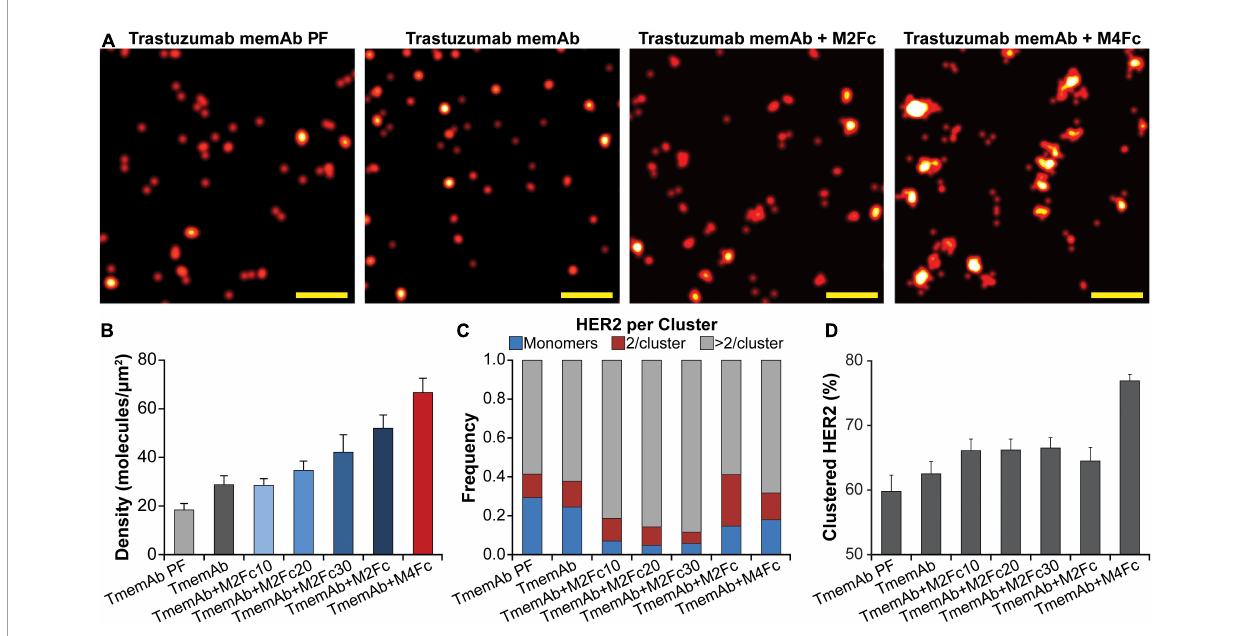
FIGURE3 Trastuzumab memAb and multivalent meditopes induce HER2 reorganization. (A) SMLM images of AF647 labeled trastuzumab memAb (TmemAb) targeting HER2 on BT-474 cells. Live cells were incubated with 10 nM TmemAb-AF647, alone or premixed with 10 nM multivalent meditope (i.e., M2Fc and its variants or M4Fc), for 10 min at 37 ◦ C and subsequently fixed. Alternatively, cells were stained with 10 nM TmemAb-AF647 postfixation (PF). Scale bars: 200 nm. (B) Average molecular density of HER2 detected with TmemAb; the p values are provided in Supplementary Table 1 . (C) Fraction of TmemAb-bound HER2 identified as an isolated receptor (blue), within a cluster of two receptors (red), or as part of a cluster with more than two receptors (gray). (D) Percentage of clustered proteins within a given ROI; the p values are provided in Supplementary Table 2 . Quantitative analysis (B–D) used the following cell and region of interest (ROI; 18 µ m 2 ) statistics: TmemAb PF (14 cells, 29 ROI), TmemAb (14 cells, 34 ROI), TmemAb + M2Fc10 (16 cells, 40 ROI), TmemAb + M2Fc20 (17 cells, 39 ROI), TmemAb + M2Fc30 (15 cells, 35 ROI), TmemAb + M2Fc (23 cells, 43 ROI), and TmemAb + M4Fc (24 cells, 57